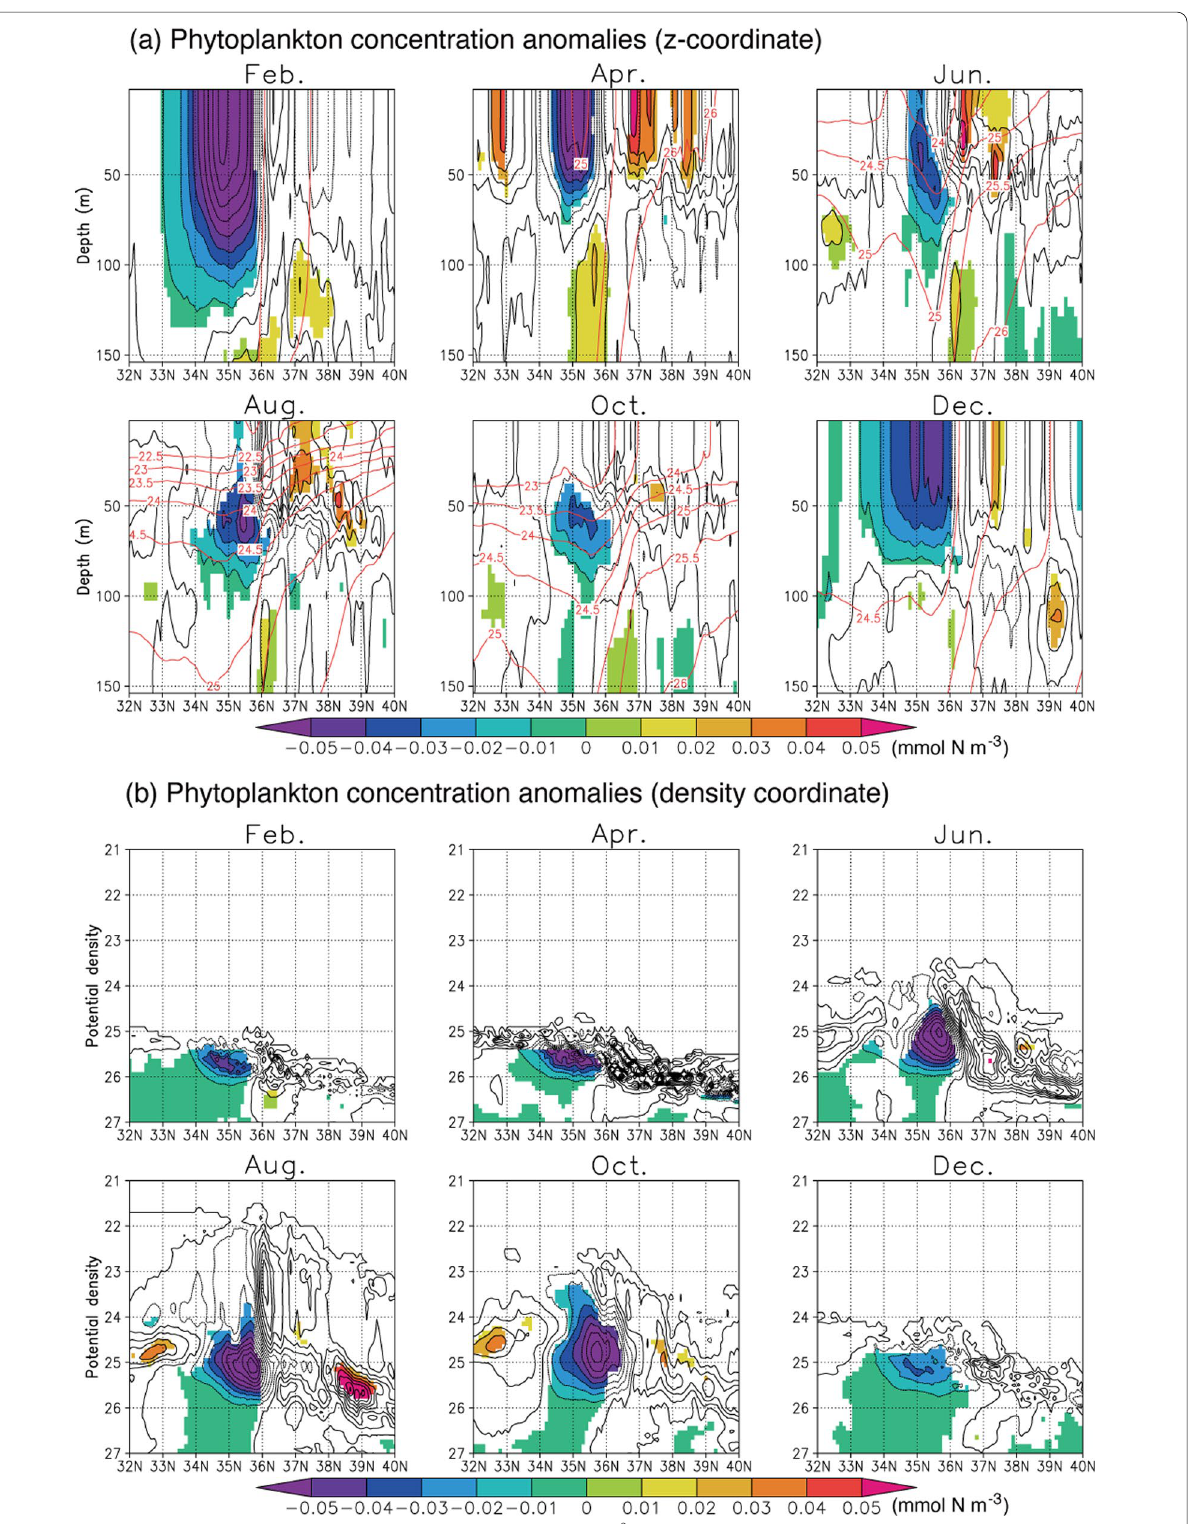
Fig. 5 Composites of phytoplankton concentration anomalies (in mmol N m − 3 ) along 145°E in the upstream KE during the stable states in a the z-coordinate and b the density coordinate. The black contour intervals are 0.01 mmol N m − 3 . Also shown in ( a ) with red contours are composites of potential density. Anomalies significant at the 95% confidence level by a two-tailed t test are